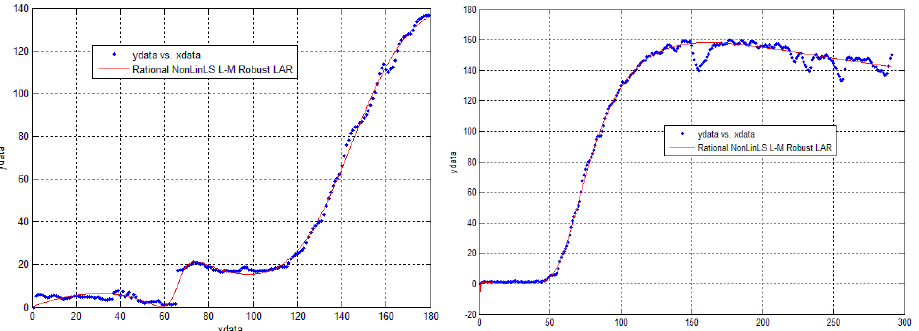
Figure 2. Curve Fitting Results. The algorithm used for calculating the polynomial coefficients was Levenberg-Marquardt. The best result was obtained for m = n = 5.